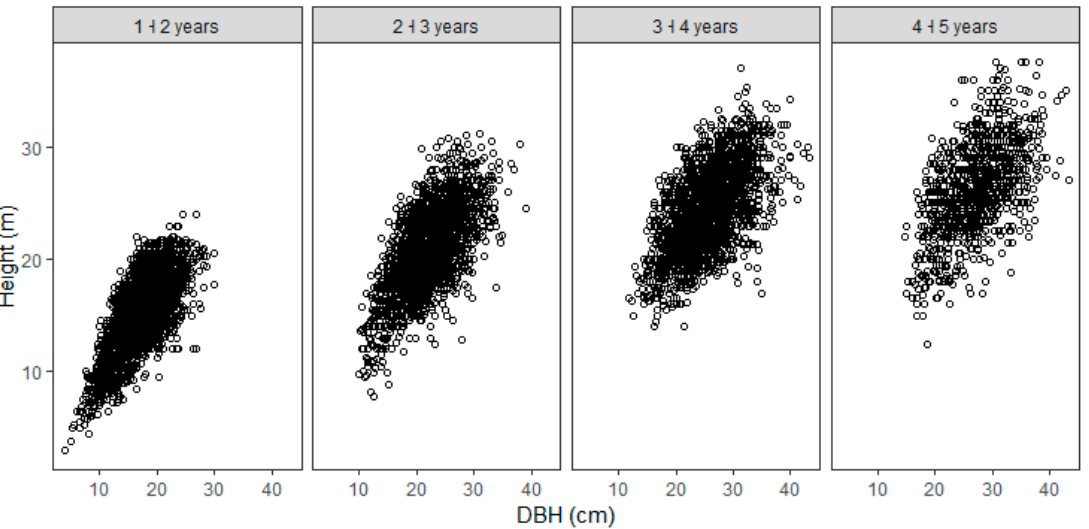
Figure 1. Dispersion of paired diameter at breast height (DBH) and h data in fit and validation data-sets used to represent the height–diameter relationship (Approach 1).